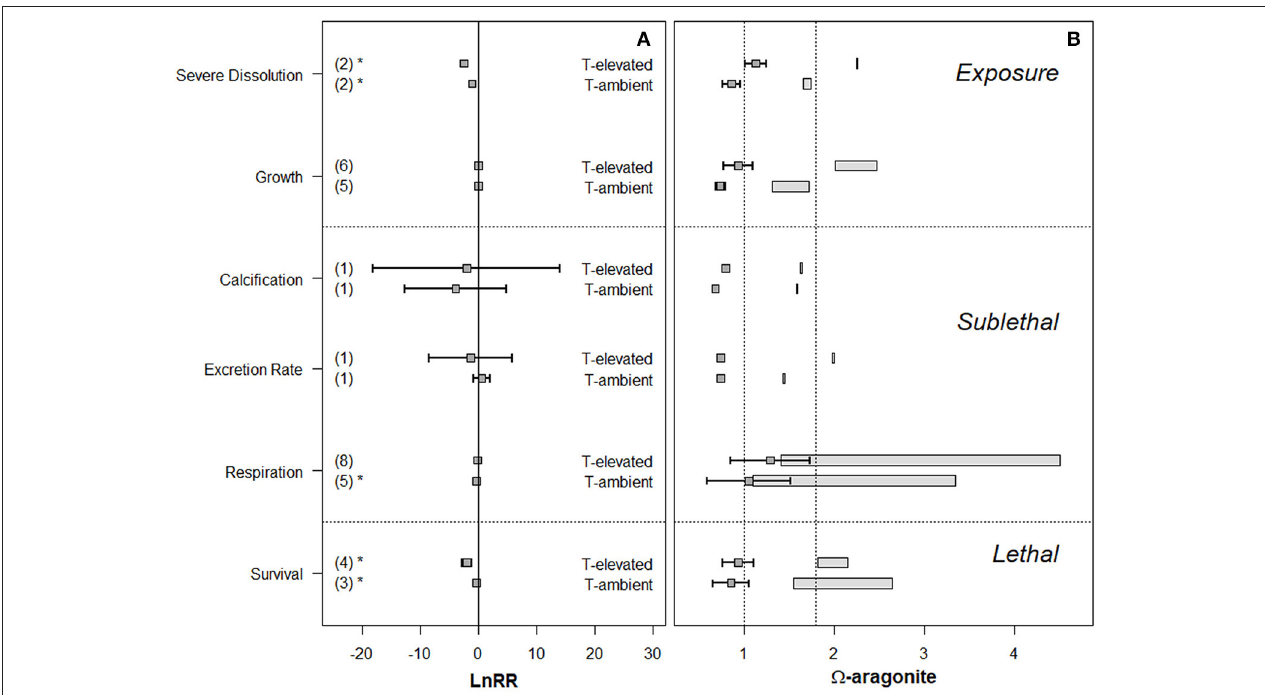
FIGURE 5 | Meta-analysis of OA ( (cid:127) ar ) and warming effects on the variety of response measures at ambient and elevated temperature, with underlying (cid:127) ar conditions (A) Forest plot of (cid:127) ar and thermal effect across exposure response, sublethal, and lethal responses in pteropods. The numbers in the parenthesis indicate the number of experiments for each response measure. LnRR (Logarithmic response ratios) indicates the magnitude of response with its significance ( p < 0.05) indicated by the asterisks. (B) “Effect” (box-and-whiskers) and “control” (rectangles) conditions as used in the experimental conditions, with the dotted line positioned at (cid:127) ar = 1 and 1.8 for comparison with known biogeochemical (cid:127) ar thresholds.